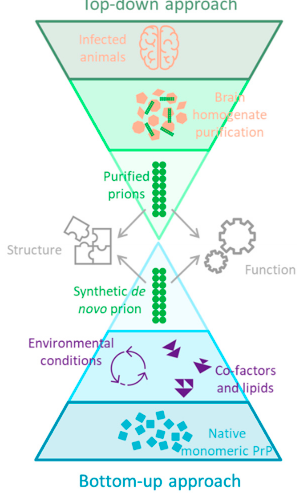
Figure 1. An outline of the top-down and bottom-up approach for investigating prions. The top- down approach has largely been achieved, with the high resolution structures of two prion strains having been recently solved [17], as well as many more structures of other amyloid classes [18]. The bottom-up approach starts from simplified components and aims to produce a prion with the same structure and biological activity as the brain-derived prions. This approach requires identification of any potential co-factors, and so provides further understanding of the disease process. It allows for modulation of the process by adding potential inhibitors or accelerators, and so contributes to the development of